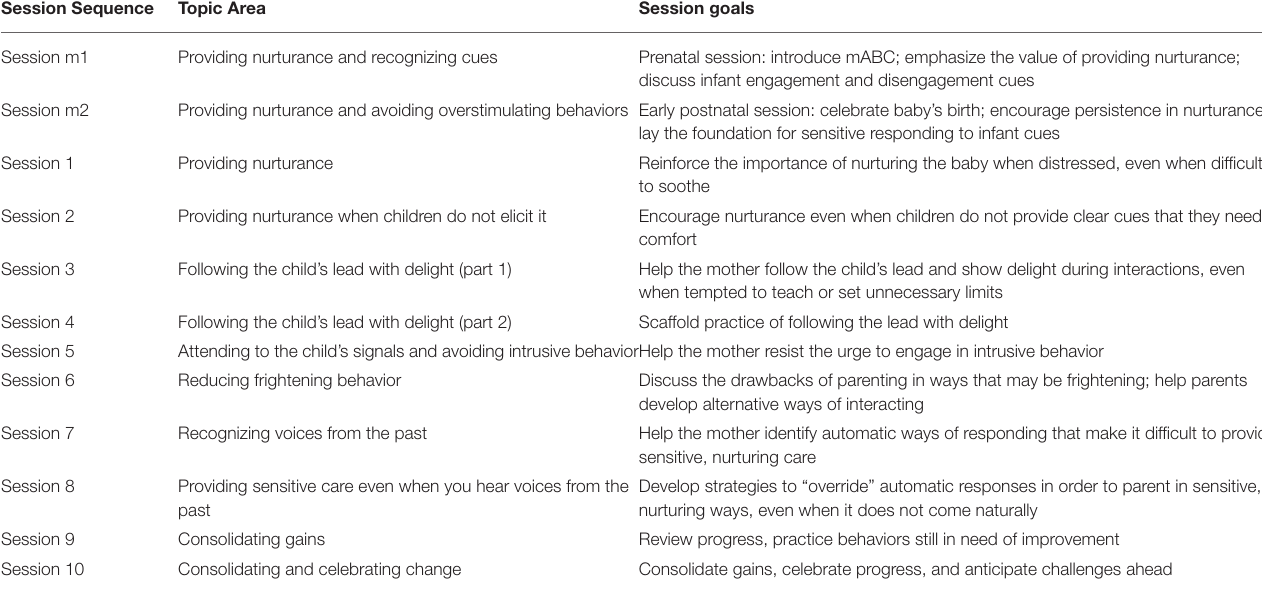
TABLE 3 | Overview of mABC topic area by session. Session Sequence Topic Area Session